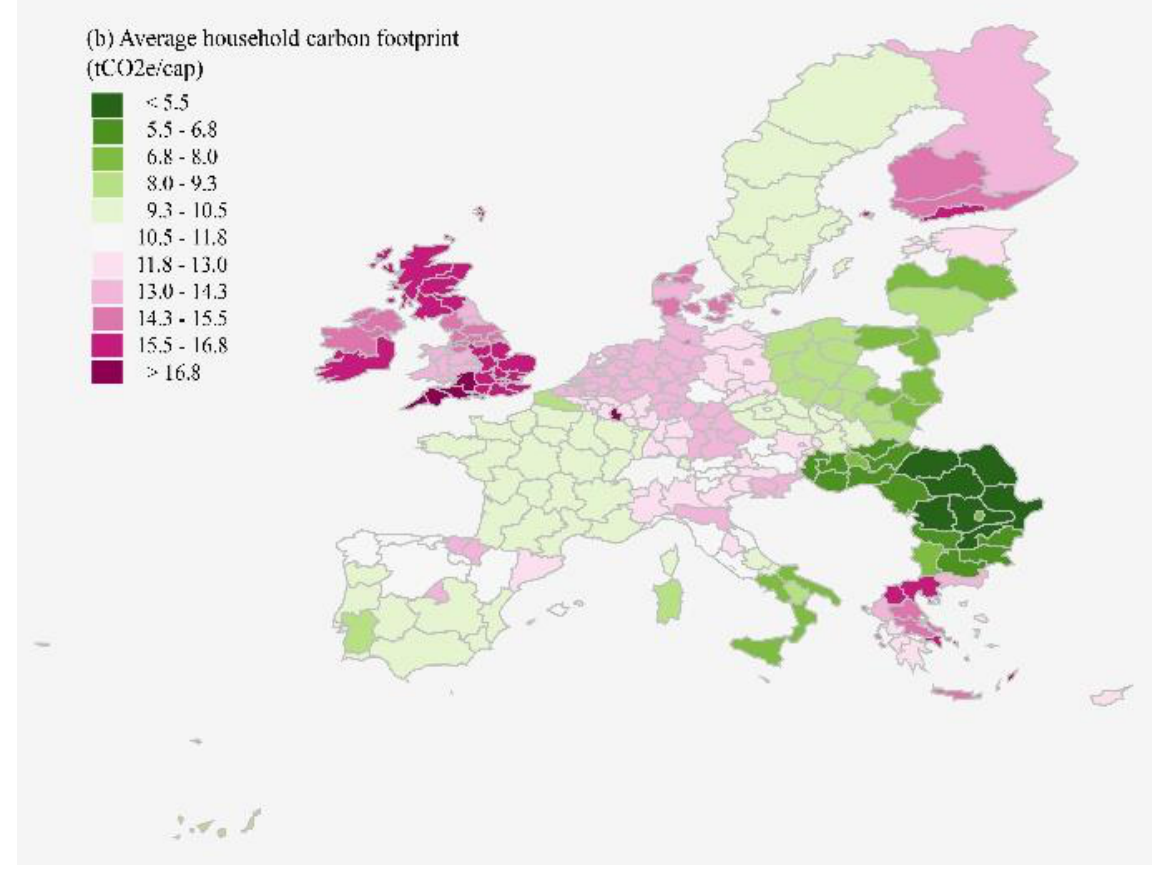
Figure 2: Average household carbon footprint (Hennigan,